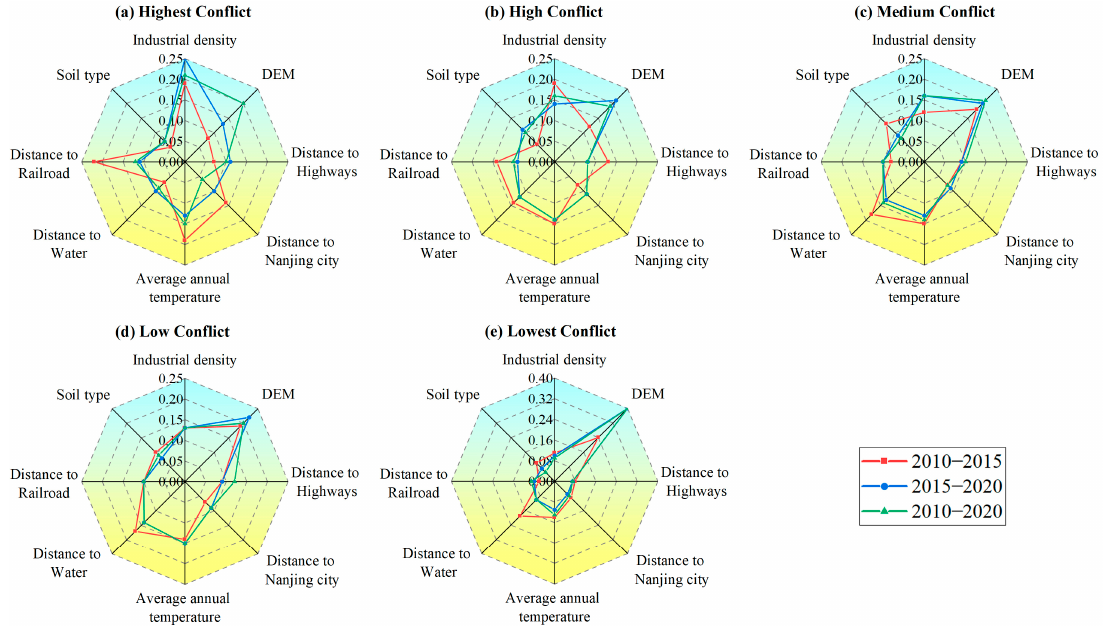
Figure 9. Driving factors of the ecological-economic spatial change. Table 5. Random forest accuracy by RMSE.